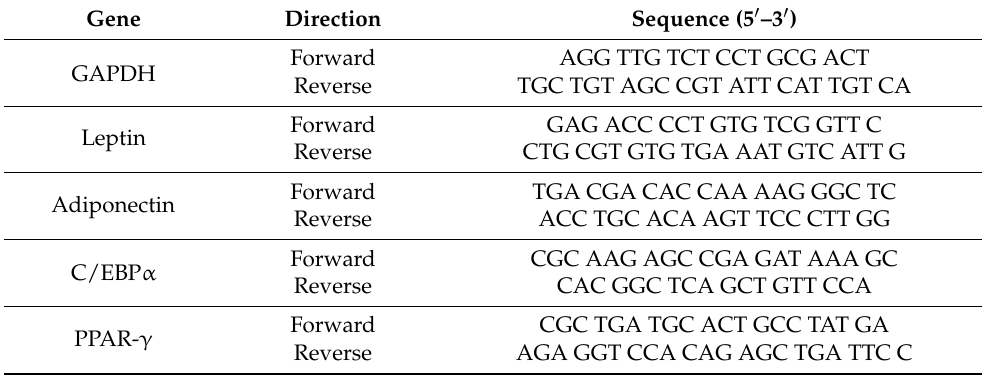
Table 1. Primer sequences used in the qRT-PCR assays.